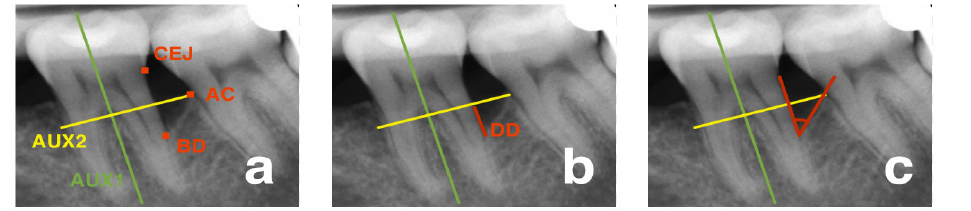
Figure 2. Radiographic measurement of the intra-bony defect. ( a ) AUX1—auxiliary line 1, AUX2—auxiliary line 2, CEJ—cemento–enamel junction, AC—alveoral crest, BD—base of the defect. ( b ) DD—defect depth. ( c ) Defect angle.